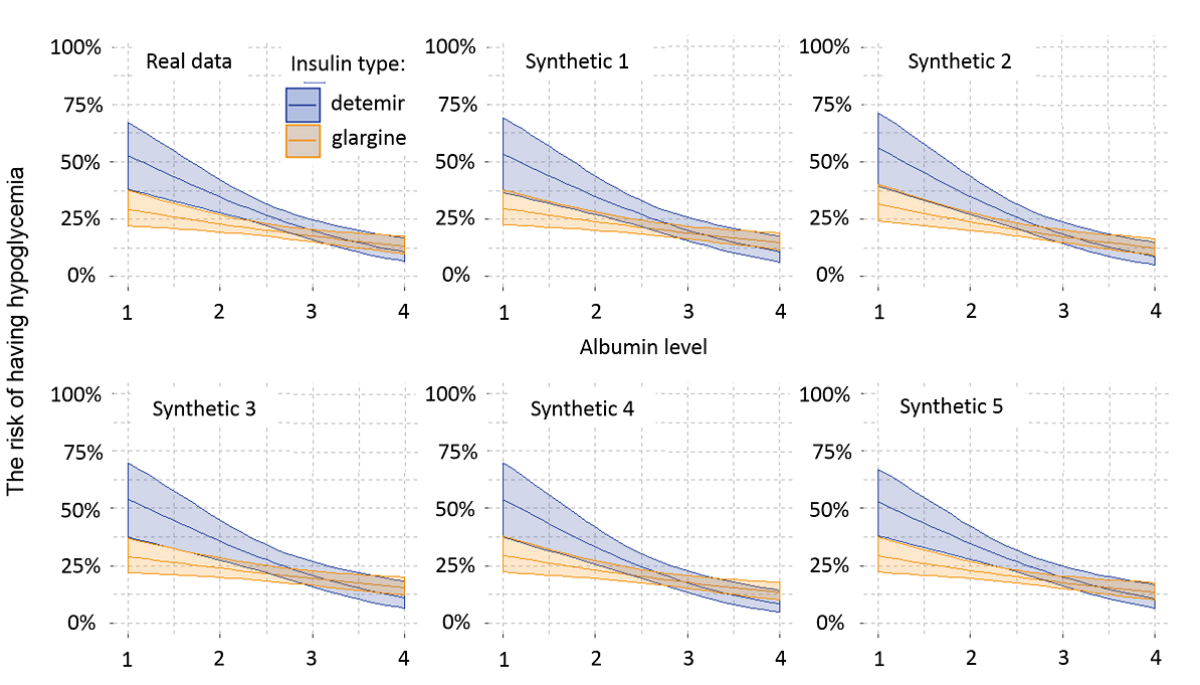
Figure 7. Risk predictions with 95% confidence intervals for detemir and glargine insulin treatments for a range of albumin values, based on the real data (top left) and five synthetic datasets (other panels). The risks estimated from the synthetic sets were highly similar to the curves estimated from the real data, and consistently indicated association of detemir use with a higher prevalence of hypoglycemic events in patients with hypoalbuminemia.